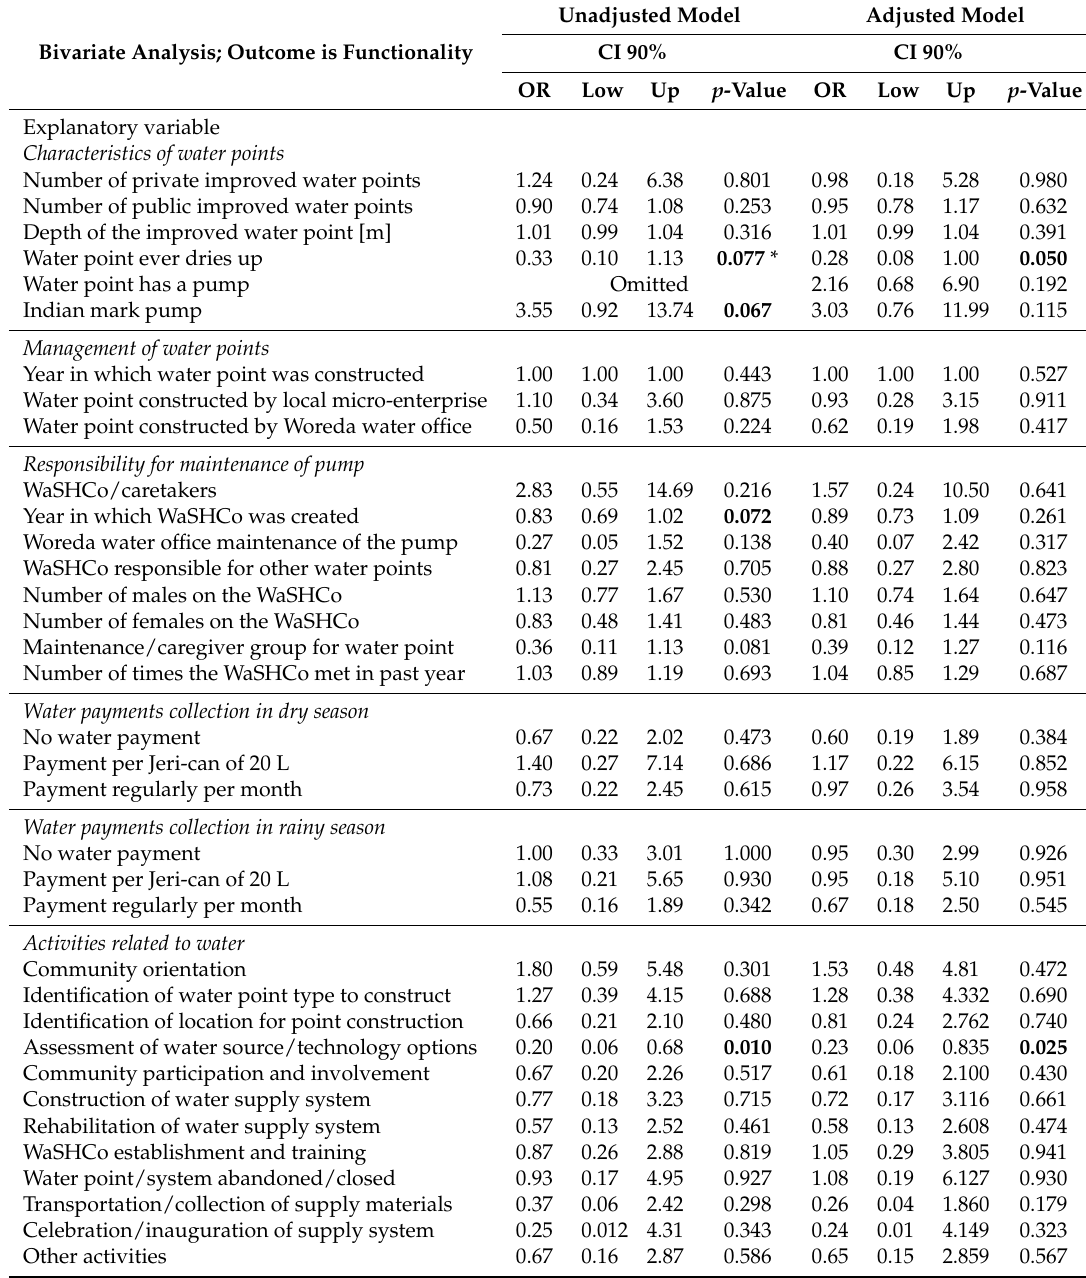
Table 8. Bivariate logistic regression results for the use of basic water